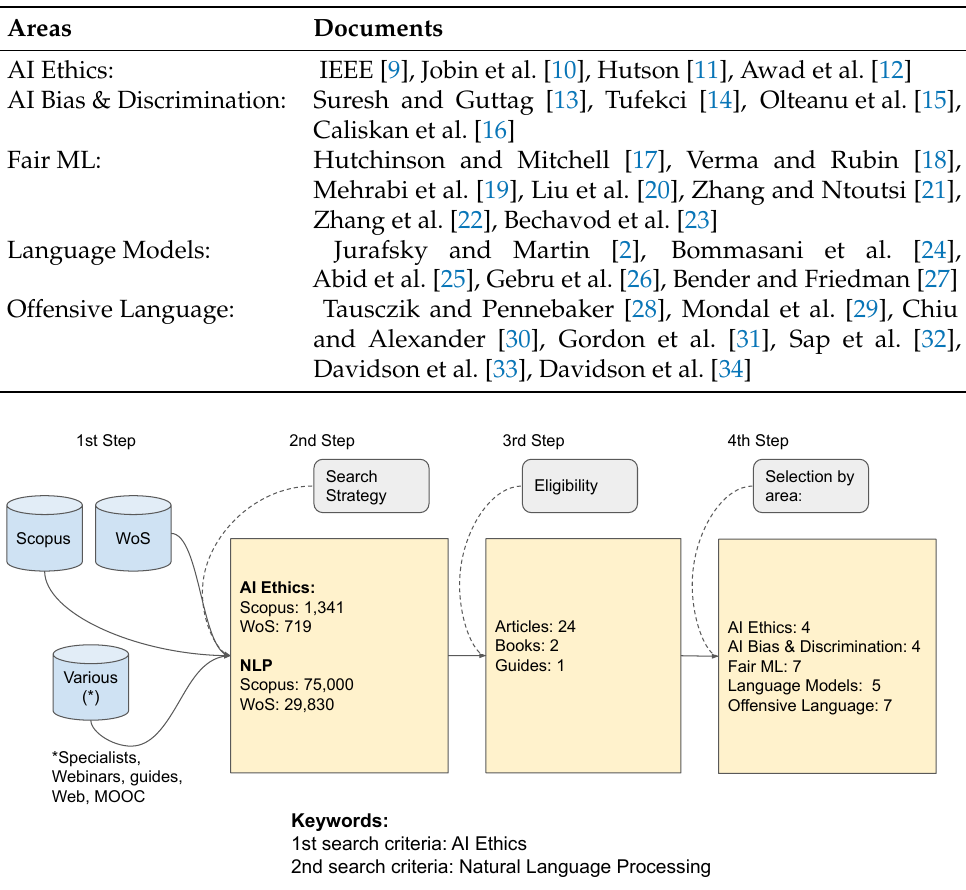
Figure 1. Systematic mapping